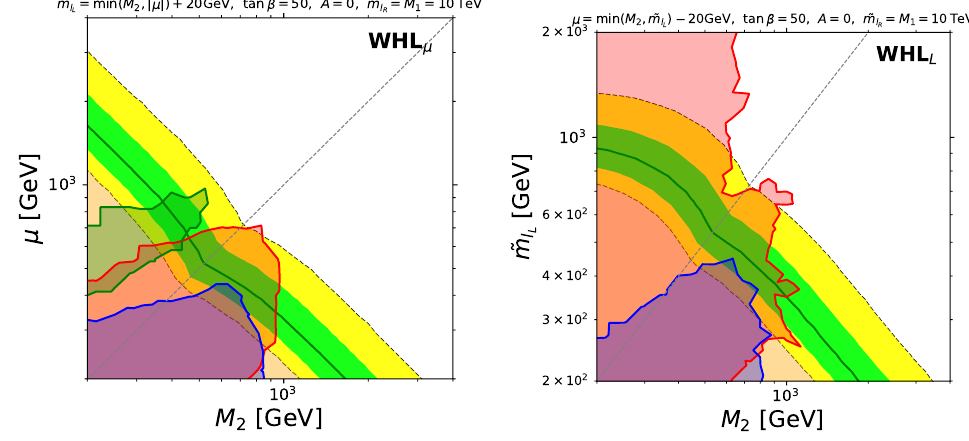
Figure 6 . Results for RPV WHL µ (left) and WHL L (right) planes. Region of parameter space allowed by the latest a experimental results [4] is depicted with green and yellow bands, corre- µ sponding to one and two sigma agreement respectively. Orange shaded region corresponds to a bigger than experimental value by more than 2 sigma. Red, green and blue shaded regions are excluded by LHC